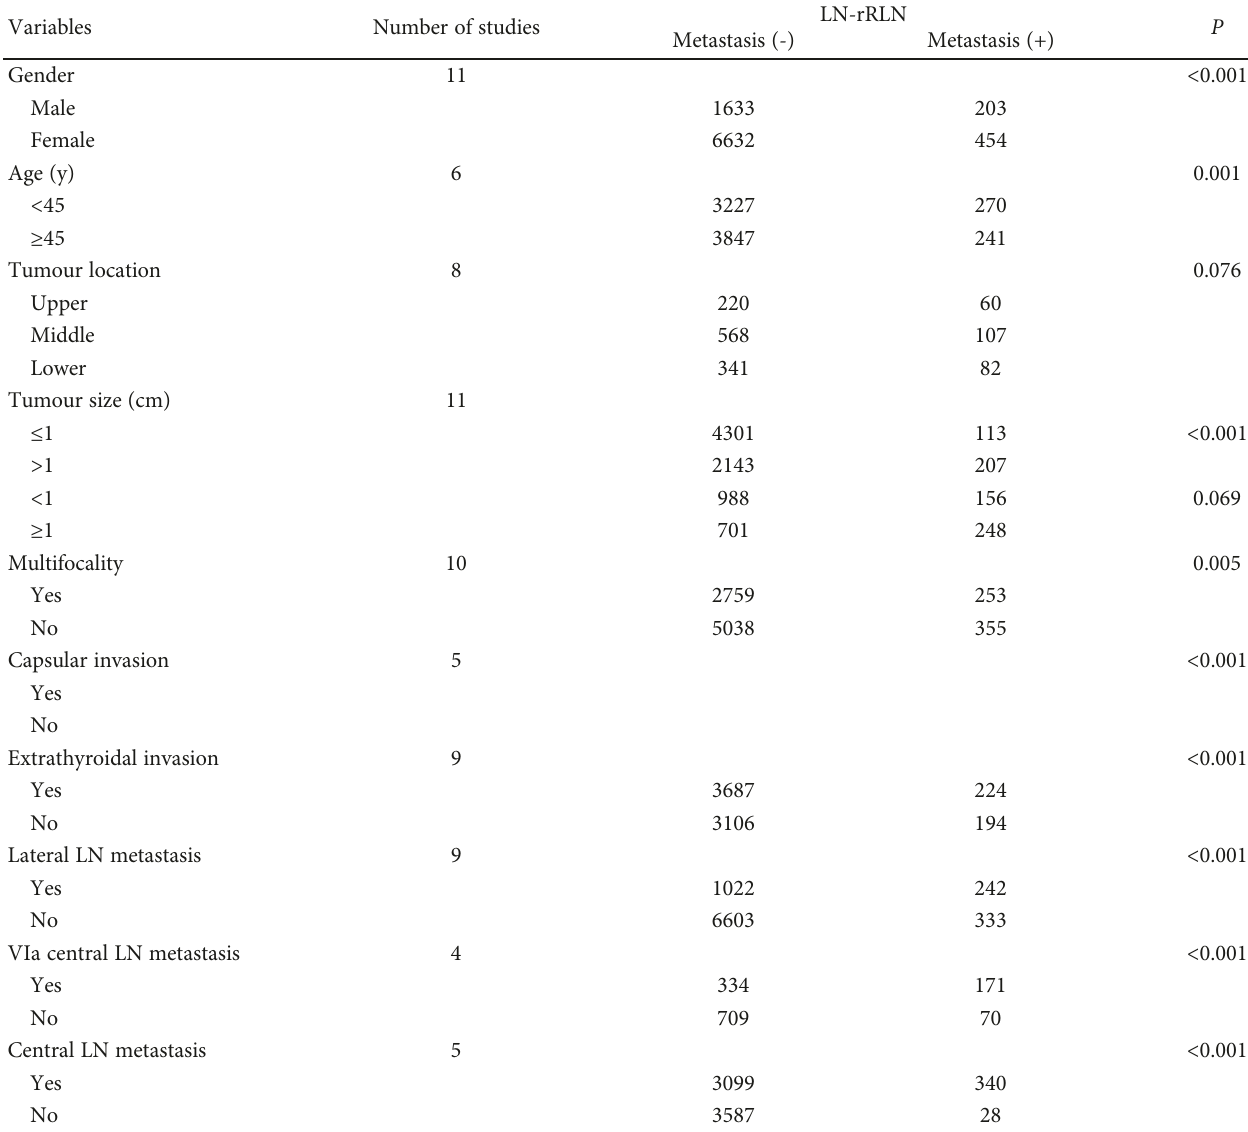
Table 1: Clinicopathological characteristics associated with metastasis to LN-rRLN in PTC